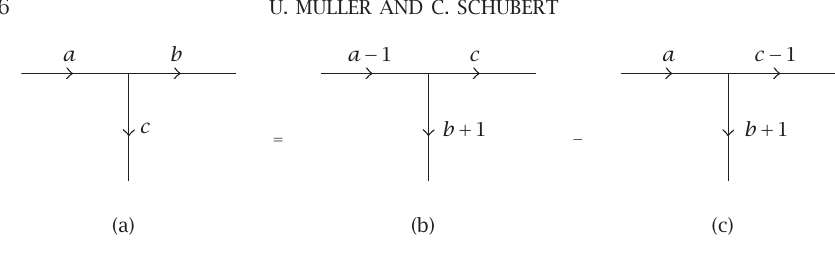
Figure 4.3 . Integration by